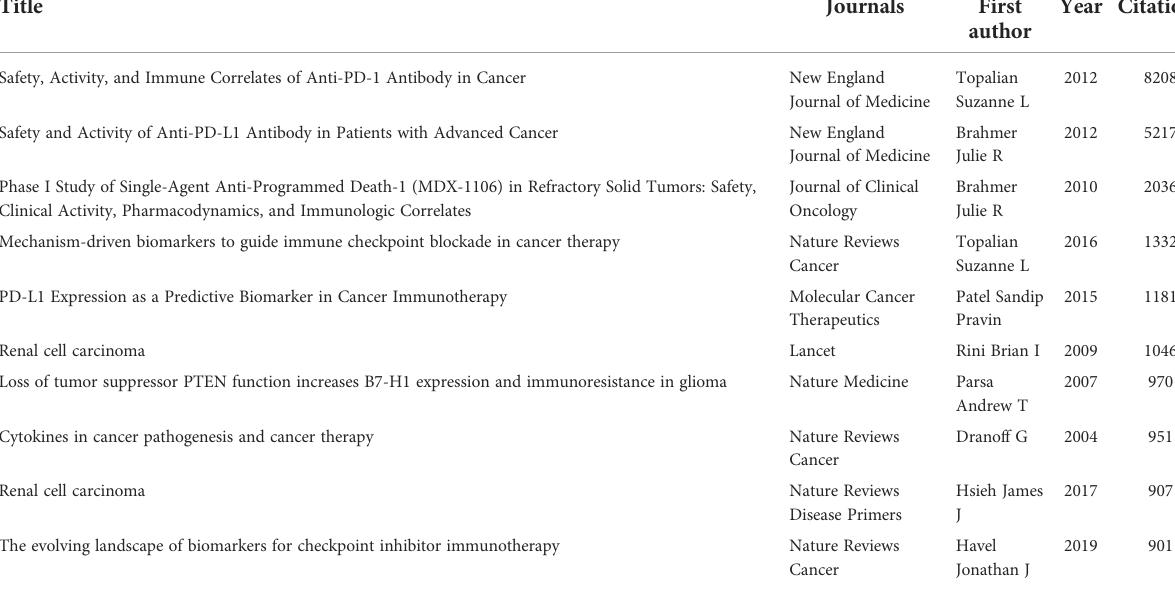
TABLE 5 Top 10 cited papers concerning the research of RCC immunotherapy.